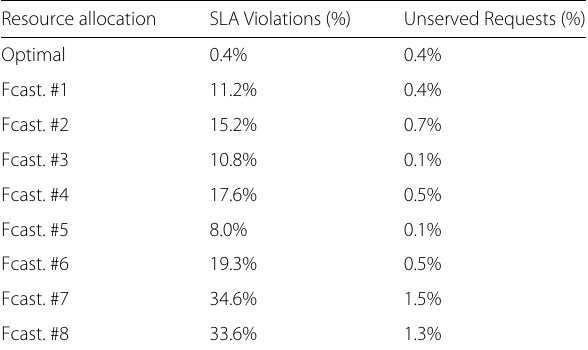
Table 7 Percentage of SLA violations and unserved requests over total number of requests for the 24 h test interval, based on the resource allocation of Table